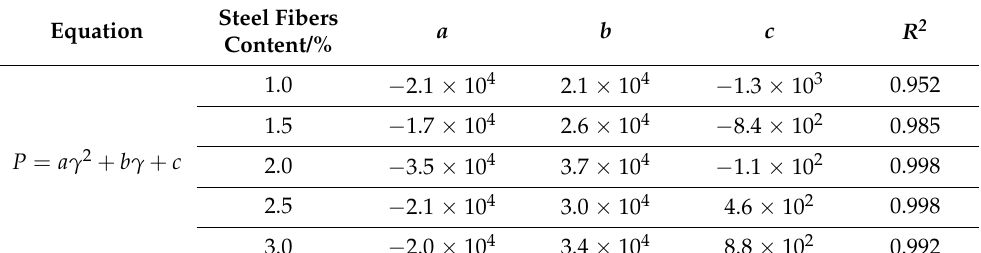
Figure 10. The load-mid-span deflection curves and the corresponding fitting results. ( a ) Load- mid-span deflection curves. ( b ) The fitting results load-mid-span deflection curves. Table 4. The fitting results of the relationship between the flexural load and the mid-span deflection. Steel Fibers Con- Equation